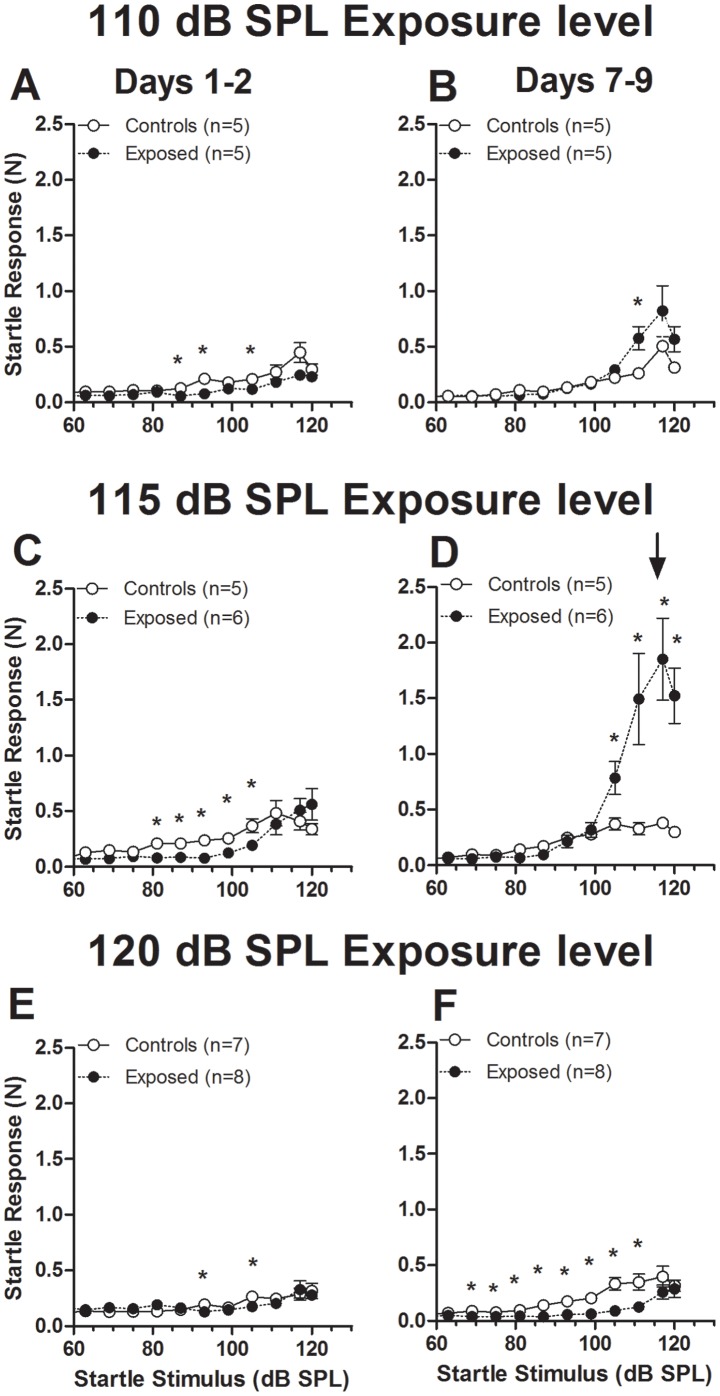
Effects of exposure level on ASR growth curves for early (1–2 days) and late (7–9 days) post-exposure time frames.A–B. Data for animals exposed at 110 dB SPL. C–D. Data for animals exposed at 115 dB SPL. E–F. Data for animals exposed at 120 dB SPL. Each point represents the mean (±S.E.M.). Group sizes are indicated in the graphs. Asterisks indicate points where differences between exposed and control animals were statistically significant (p<0.05).